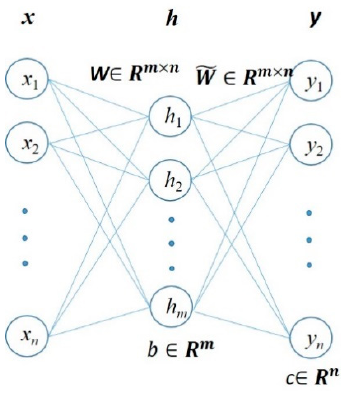
Figure 2. The structure of an autoencoder.